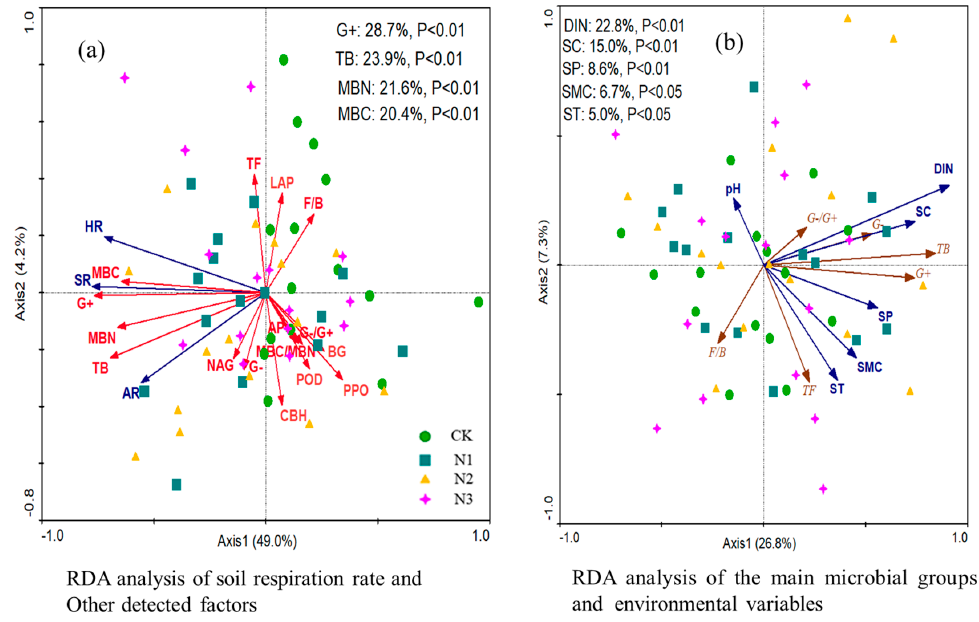
Figure 7. Redundancy analysis (RDA) of soil respiration between microbial N and microbial C. ( a ) Main microbial groups and enzyme activities; ( b ) main microbial groups and environmental variables. The structural equation models fit the significance criteria according to their x 2 , p , GFI, and RMSEA values ( x 2 = 2.949, p = 0.229, GFI = 0.995, and RMSEA = 0.051). The N application promoted